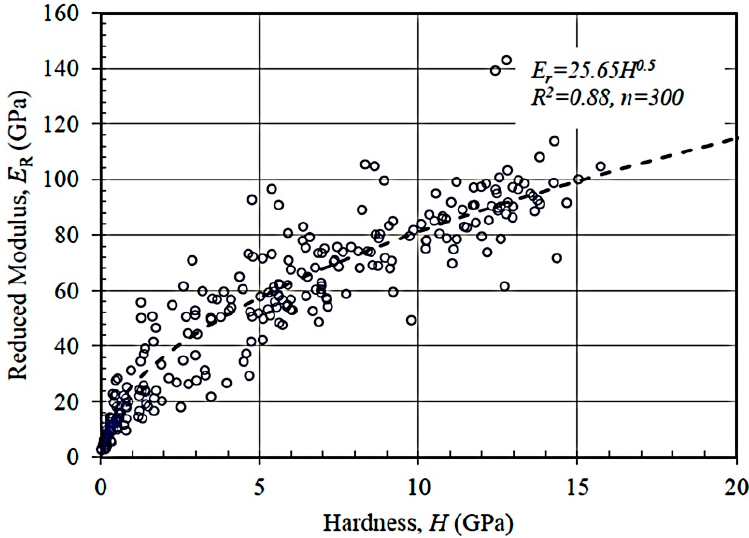
Figure 4. Relationship between indentation modulus and indentation hardness for TCC specimen ANC-1 ( h = 200–210 nm, n =